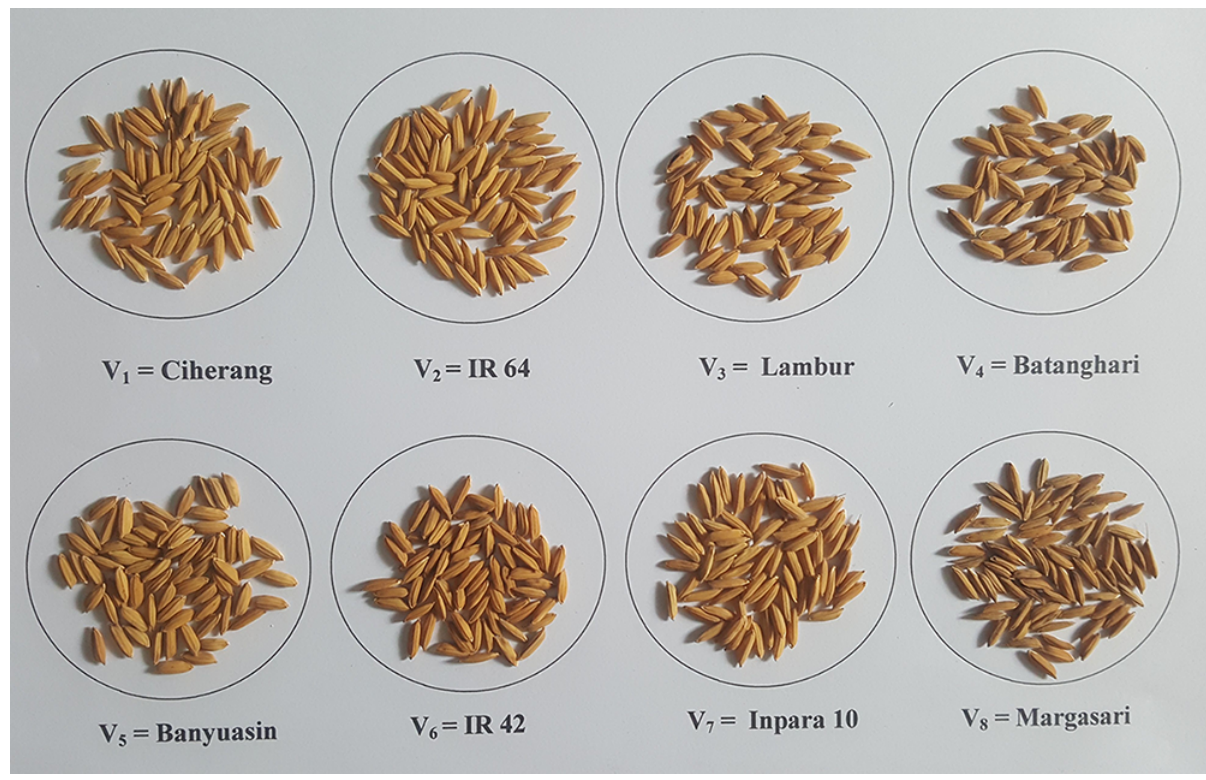
Figure 5 Morphology of grains of eight rice varieties used for